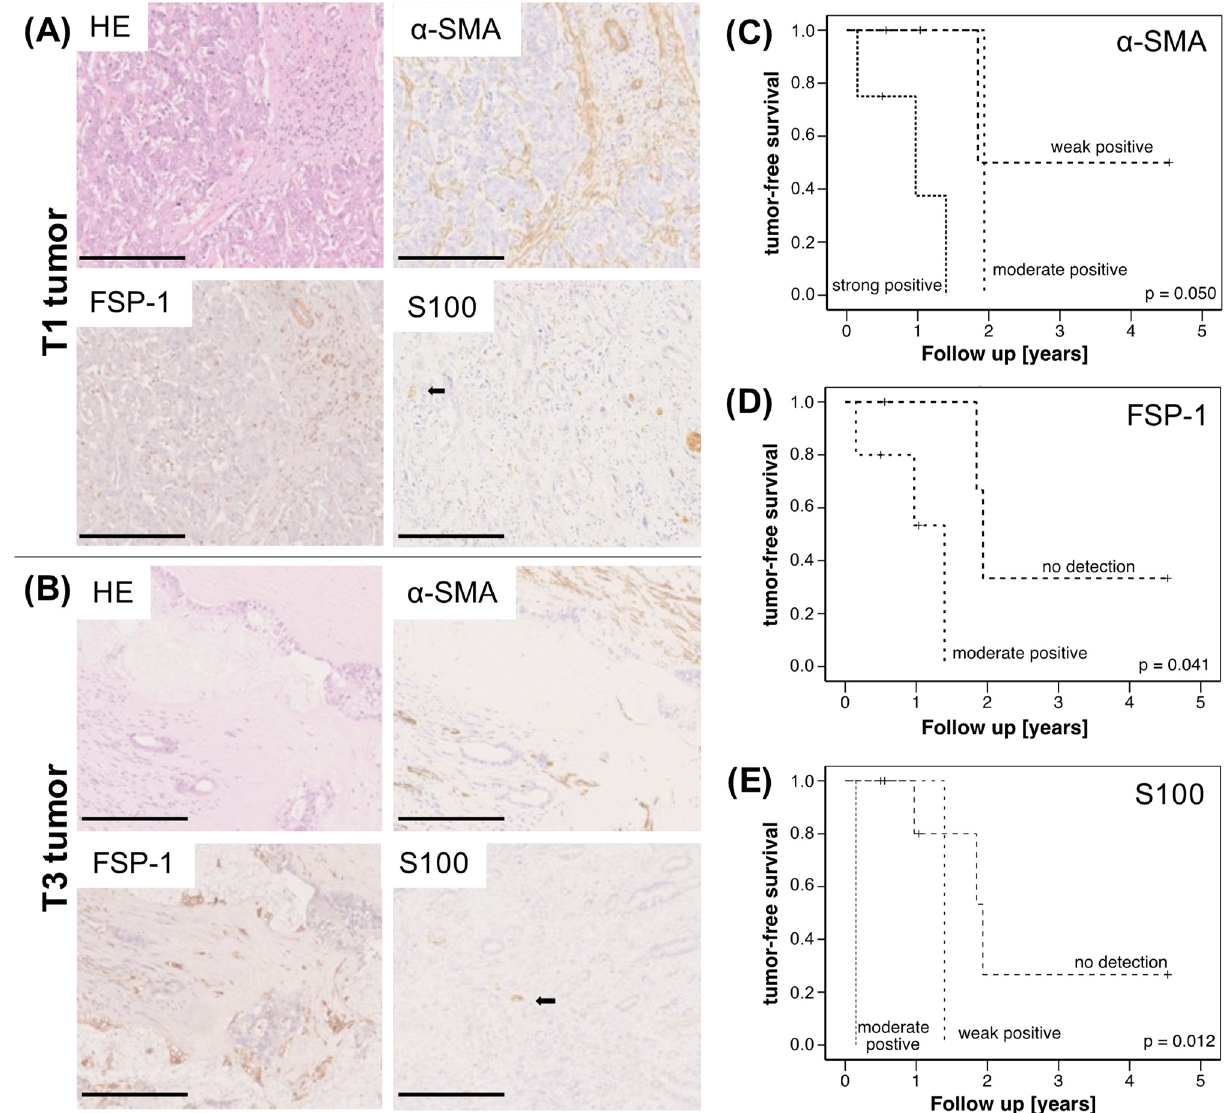
Figure 1. Immunohistochemical analysis of CCA specimens and correlation with survival of CCA patients. ( A ) Representative HE stainings and stainings for α -SMA, FSP-1 and S100 in pT1 N0 (scale bar = 250 µm) and ( B ) pT3 N0 (scale bar = 500 µm) CCA specimens. Kaplan–Meier plots for tumor-free survival of CCA patients depending on ( C ) α -SMA, ( D ) FSP-1- and ( E ) S100-expression; ( n = 14 CCA, thereof 5 with intrahepatic and 9 with extrahepatic tumors). Statistical significances are indicated in the figure.